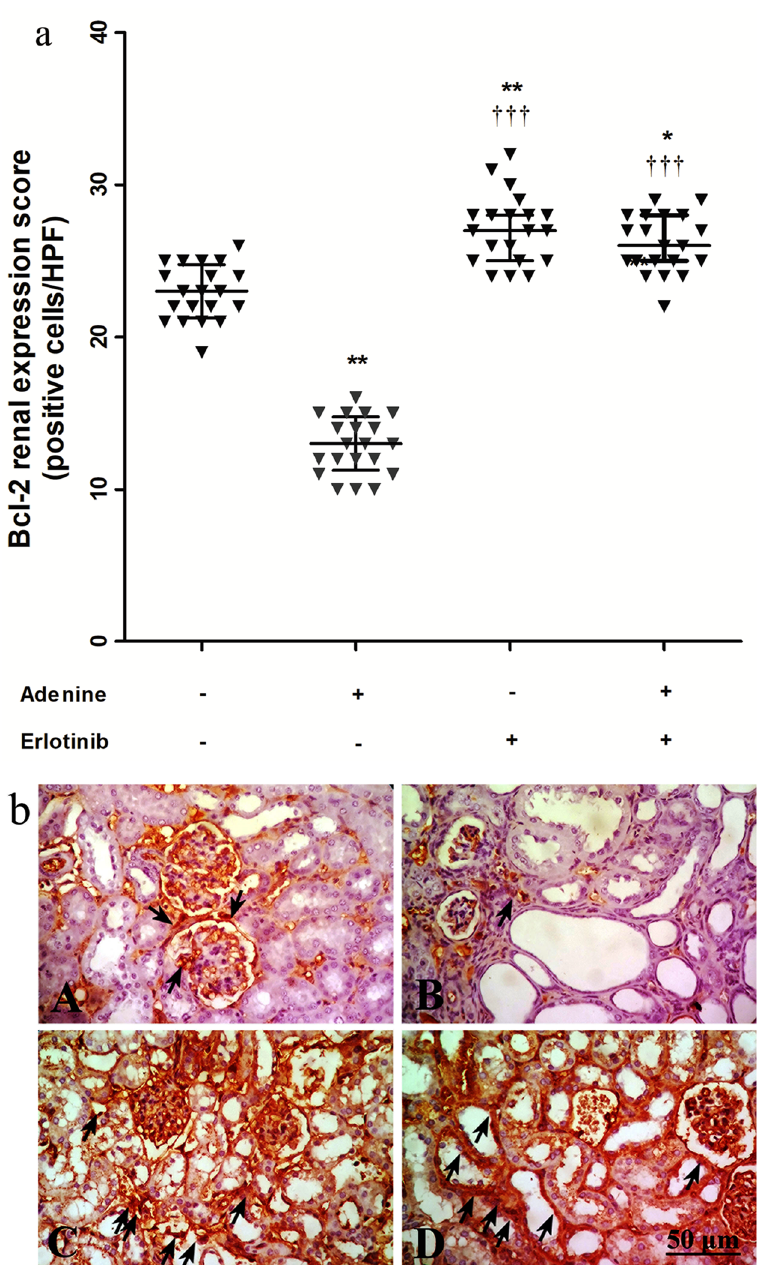
Figure 5. ( a ) Effect of erlotinib (80 mg/kg) administration on kidney expression scores of B-cell lymphoma (Bcl)-2 in adenine induced nephrotoxicity in mice. Significance: *, ** P < 0.05, 0.01 compared to control group; ‡‡‡ P < 0.001 compared to adenine group. ( b ) Representative photographs for immuno-stained kidney sections isolated from A: control group B: adenine group C: erlotinib group D: adenine + erlotinib group showing expression of Bcl-2